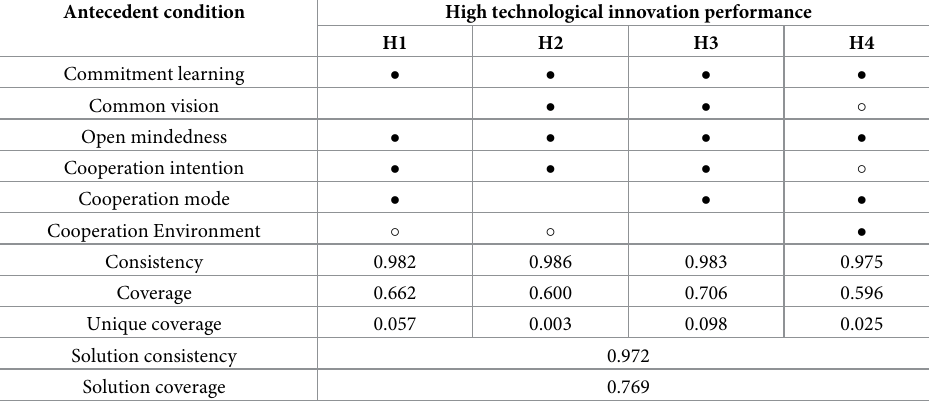
Table 6. Configuration of high technological innovation performance.